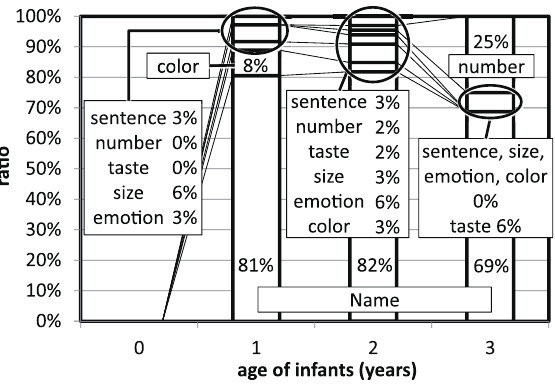
Fig. 6. Frequencies of sub-types of